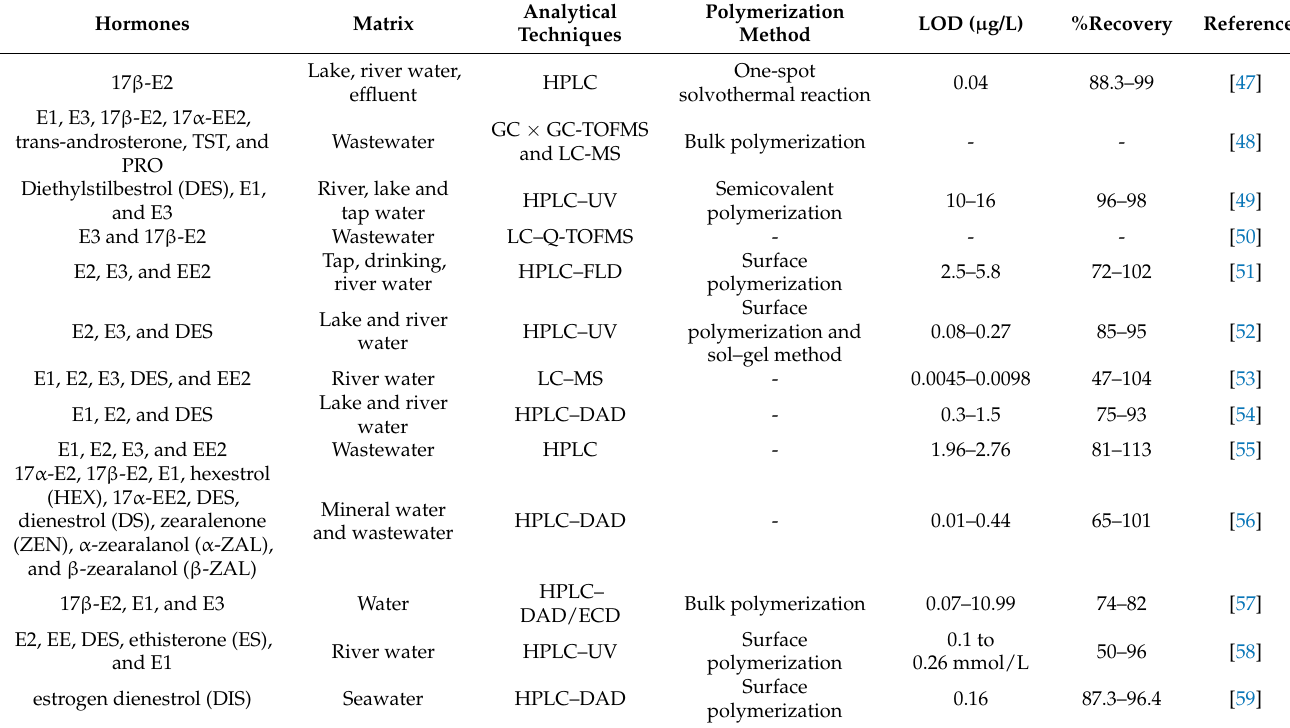
Table 2. Summary of application of MIPs for the determination of hormones in water